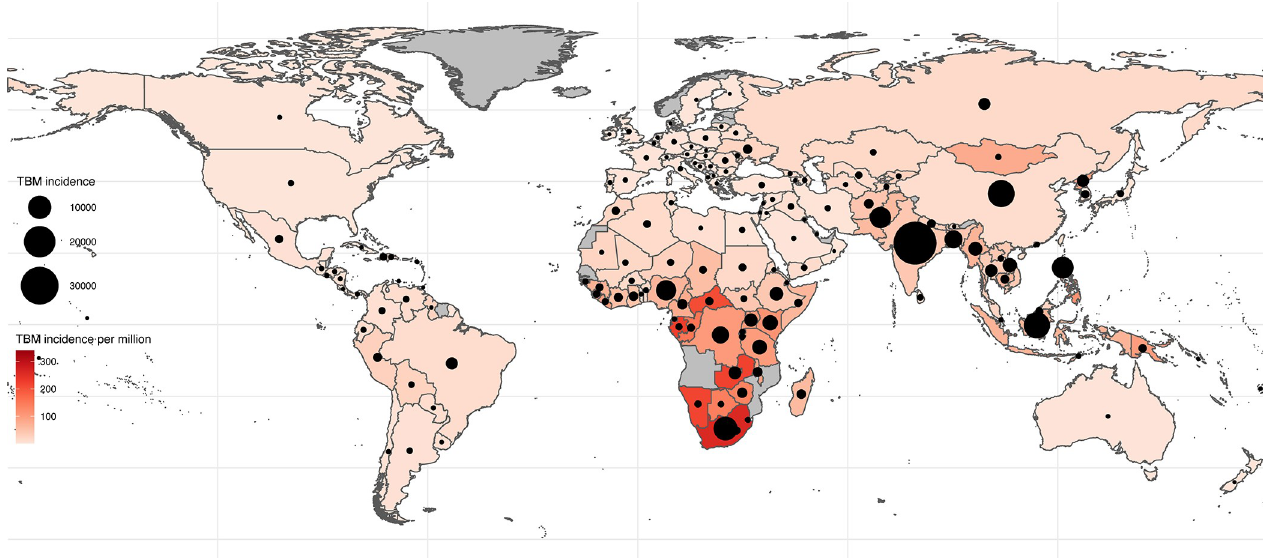
Fig 4. Absolute (dot size) and per capita incidence (colour) of TBM by